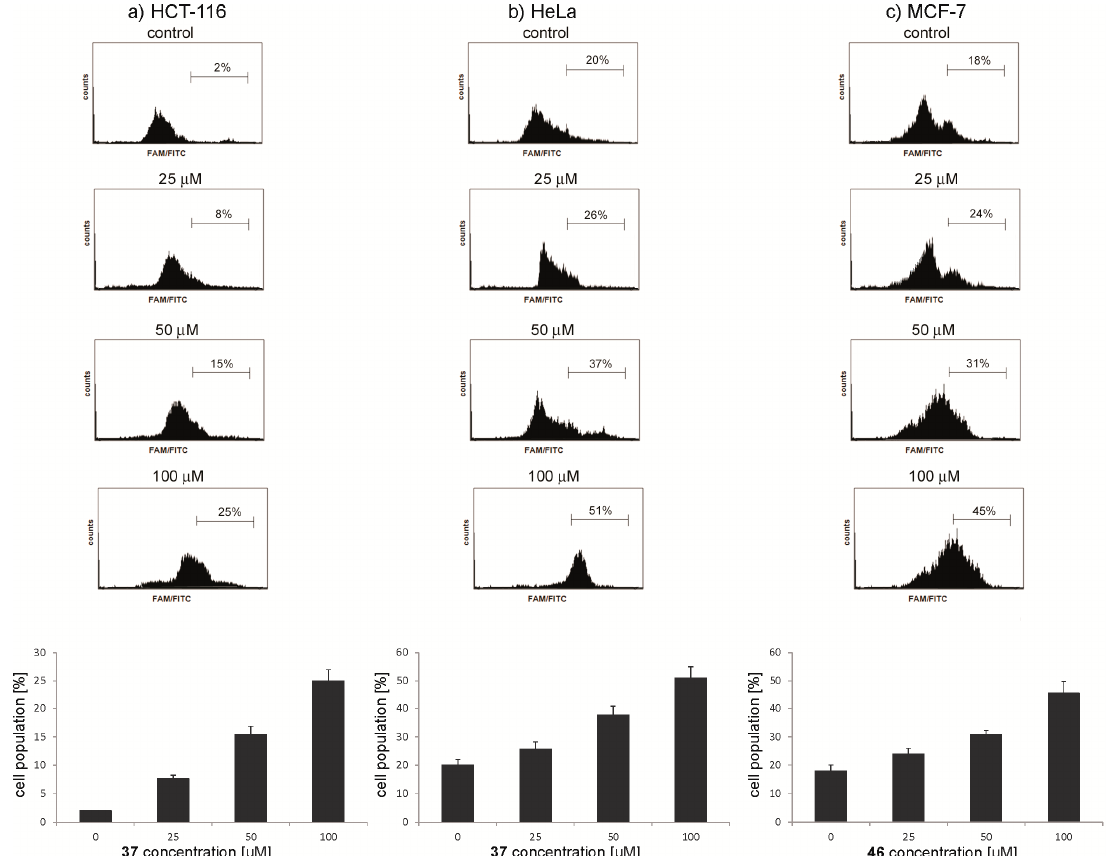
Figure 7. Induction of caspase activity in HCT-116, HeLa and MCF-7 cells by 1,2,4-triazine derivatives. HCT-116 ( a ), HeLa ( b ) and MCF-7 ( c ) cells were treated with the indicated concentrations of compounds 37 and 46 for 24 h ( a ), 72 h ( b ) and 72 h ( c ), respectively. Enzyme activity was determined by flow cytometry with the use of a caspase inhibitor, FAM-VAD-FMK. Values represent mean ˘ SD of three independent